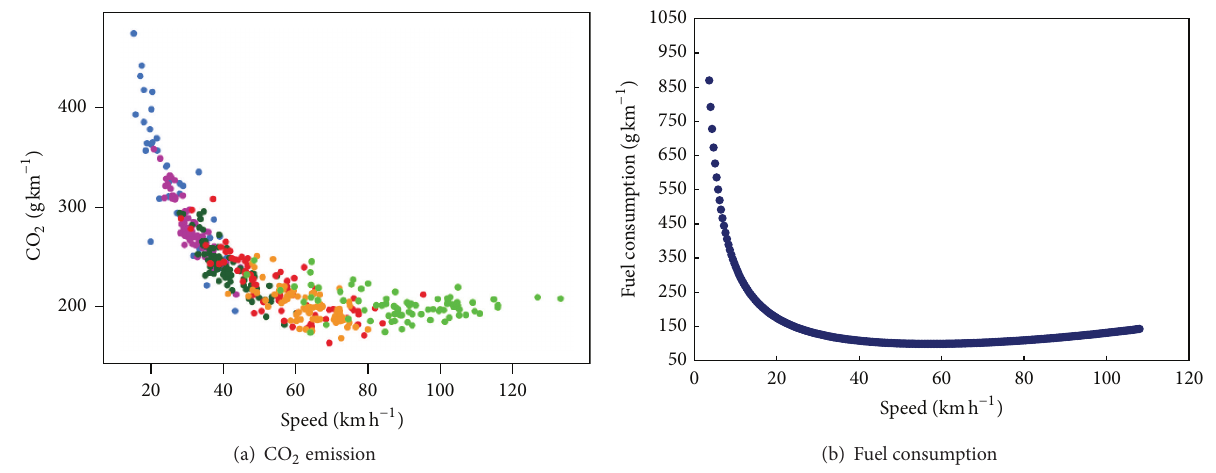
Figure 2: The relationships between driving speed and CO 2 emission and fuel